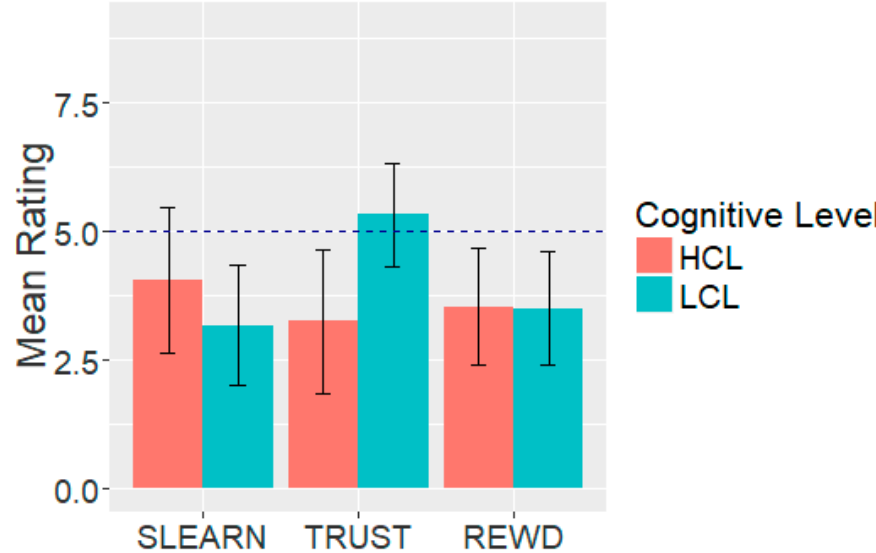
Figure 4. The effect of cognitive level on susceptibility to persuasive strategies (SLEARN = social learning, TRUST = trustworthiness, REWD = reward; horizontal bar indicates the neutral of five on the 1–9 Likert scale; HCL = high cognitive leaners, LCL = low cognitive leaners). Table 5. Between-group analysis based on cognitive level (HCL = high cognitive leaners, LCL = low cognitive leaners; n.s. = not significant). Group Social Leaning Trustworthiness Reward